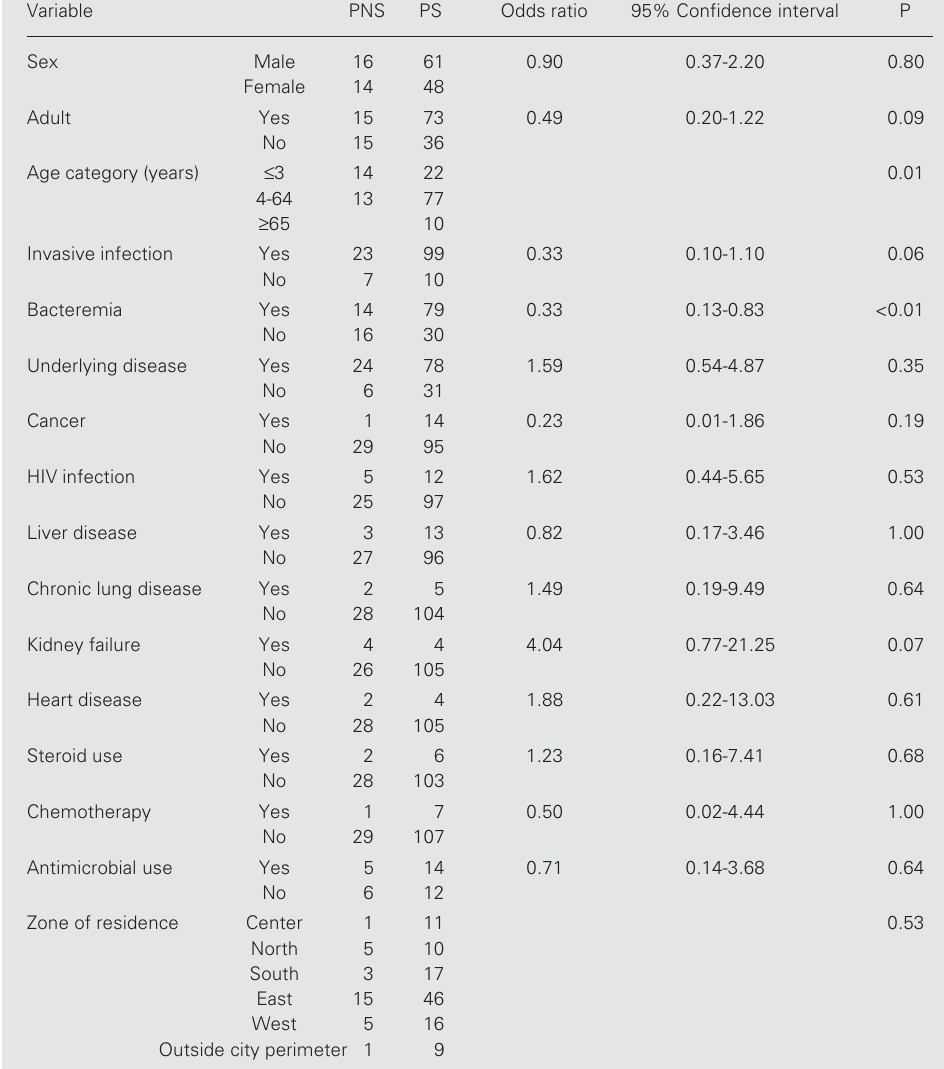
Table 1. Factors associated with infection by penicillin-nonsusceptible Streptococcus pneumoniae : univariate analysis of categorical variables.